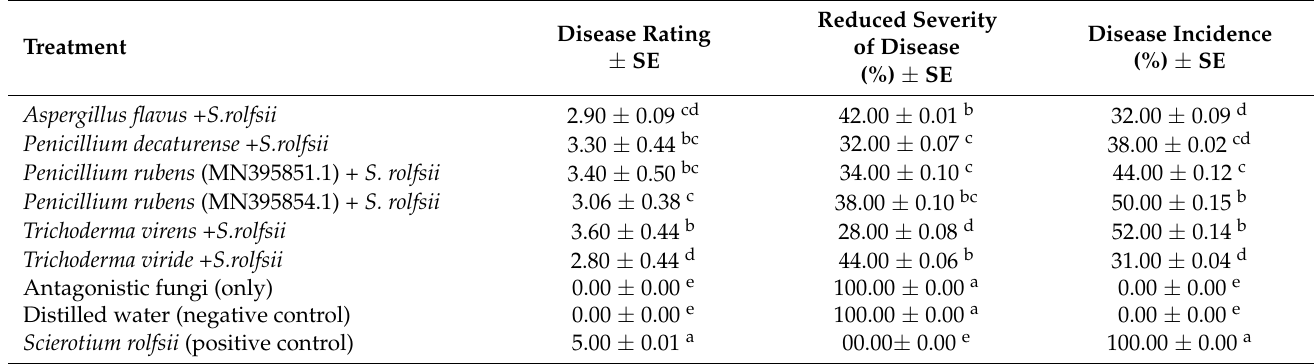
Table 3. Effect of antagonistic fungi on the disease severity, reduction in disease severity, and incidence of peanut white stem rot disease under greenhouse conditions.